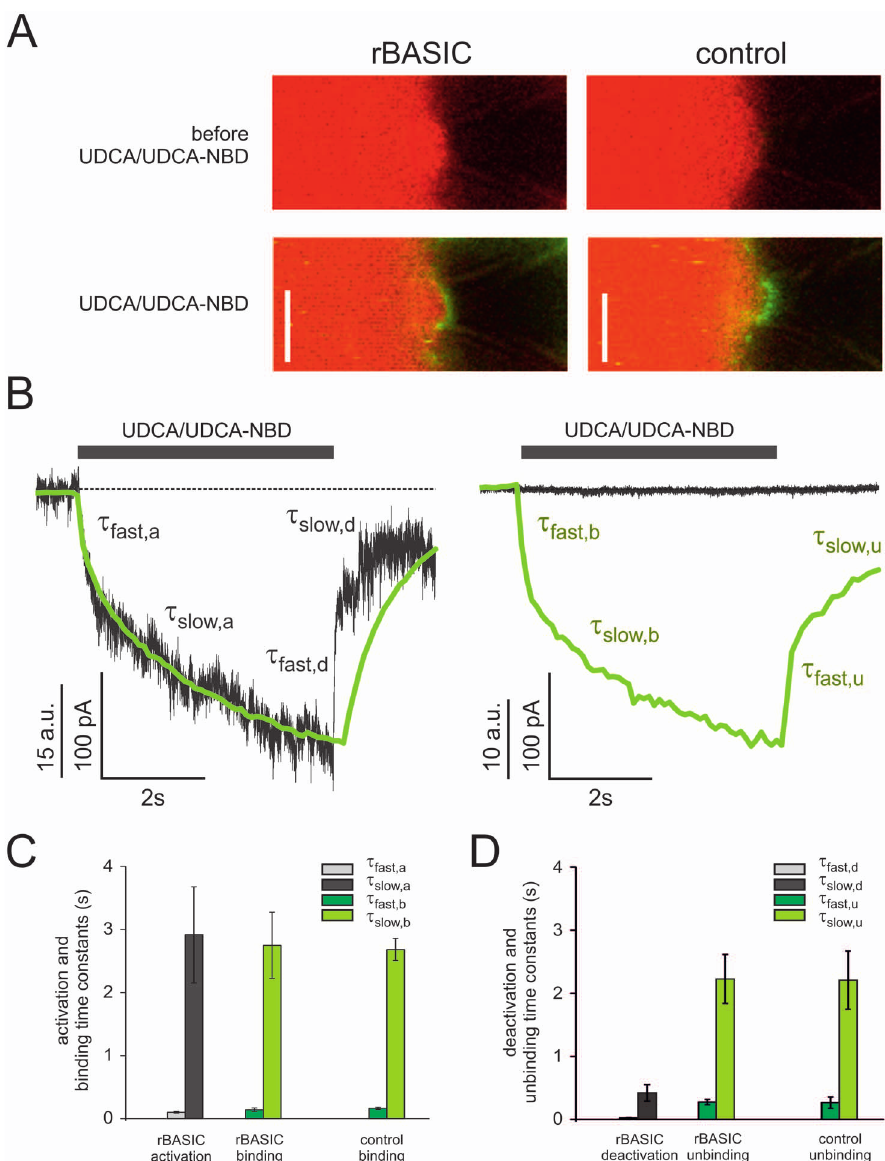
Figure 3. Correlation of UDCA membrane binding and rBASIC activation. A) Confocal images of patch pipettes containing outside-out patches excised from Xenopus laevis oocytes. Left panel, membrane patch excised from an oocyte expressing rBASIC, before (upper panel) and after (lower panel) application of UDCA-NBD/UDCA (50 m M/1.6 mM). Right panel, membrane patch excised from an uninjected control oocyte, before (upper panel) and after (lower panel) application of UDCA-NBD/UDCA. Green fluorescence signals originated from UDCA-NBD binding to the membrane, red fluorescence signal originated from DY647 background dye (1 m M) staining the bath solution. The transmission channel is overlayed. Scale bar=5 m m. B) Binding time courses and current time courses after sudden UDCA-NBD/UDCA concentration jumps, obtained from a membrane patch excised from an rBASIC expressing oocyte (left panel) and a membrane patch excised from an uninjected control oocyte (right panel). Green traces represent fluorescence signals induced by UDCA-NBD binding and unbinding to the patch membranes (for clarity, increase in fluorescence is depicted as downward deflection). Grey traces represent simultaneously recorded current traces. Averages of three consecutive measurements are shown. Time courses of activation/binding and deactivation/unbinding were fitted by the sum of two exponentials (equations (2a) and (2b)). t fast , t slow represent fast and slow time constants for rBASIC activation/inactivation and UDCA-NBD binding/unbinding events (a, rBASIC activation; b, UDCA-NBD binding; d, rBASIC deactivation; u, UDCA-NBD unbinding). C) and D) Quantitative comparison of slow and fast time constants of rBASIC activation and UDCA-NBD binding (C) and rBASIC deactivation and UDCA-NBD unbinding (D). Error bars represent SEM; n =3–7. doi:10.1371/journal.pone.0111549.g003 (Fig. 6B). This suggests that cholesterol-dependent membrane properties do not affect rBASIC activity. In contrast to rat BASIC the ortholog from mouse shows high constitutive activity and strong selectivity for Na + . To test whether it is also sensitive to its membrane environment we analyzed the